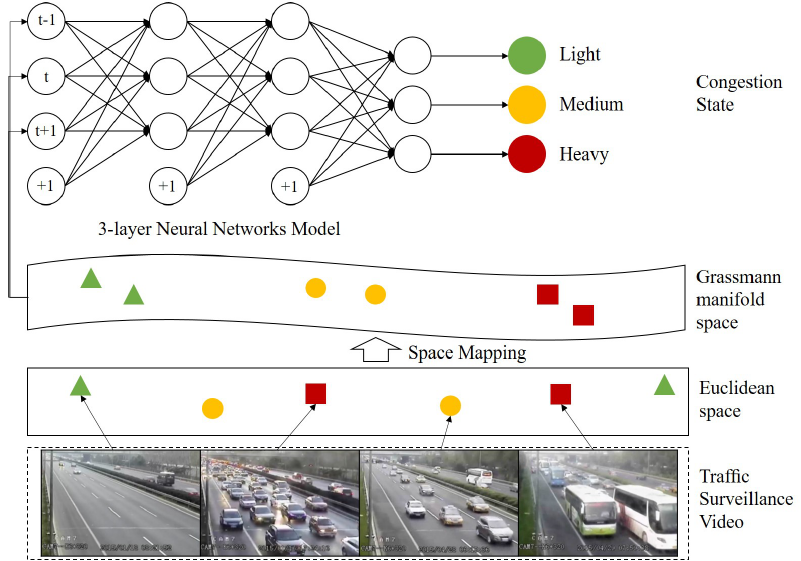
Figure 1. The data processing